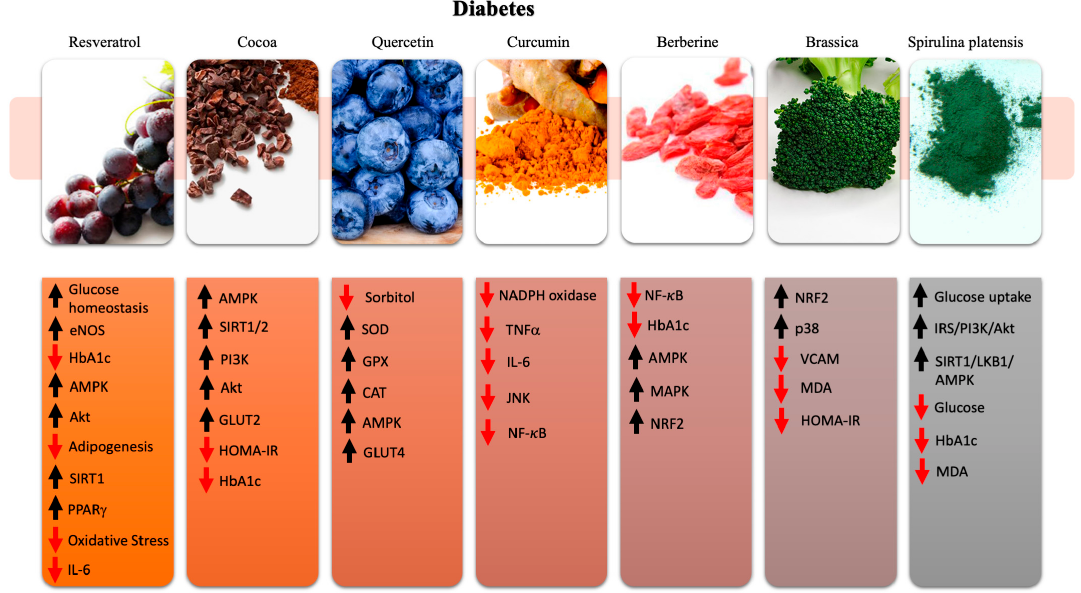
Figure 4. Summary of the main molecular and physiological effects exerted by resveratrol, cocoa, quercetin, curcumin, brassica, berberine, and Spirulina platensis in diabetes. Red arrow ( ↓ ) indicates downregulation; black arrow ( ↑ ) indicates upregulation.